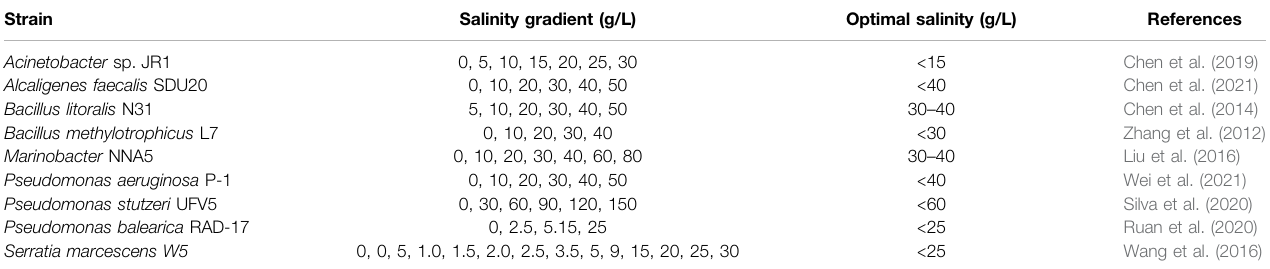
TABLE 5 | Ranges of salinity for HNADs. Strain